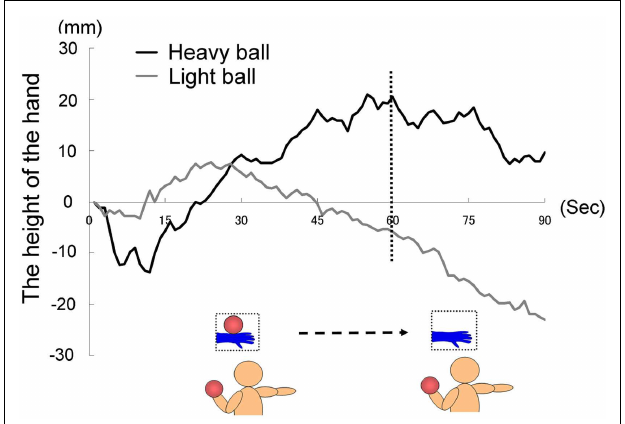
FIGURE 5 |Time course of the height of the hand (fingertips) in each group in Experiment I B.